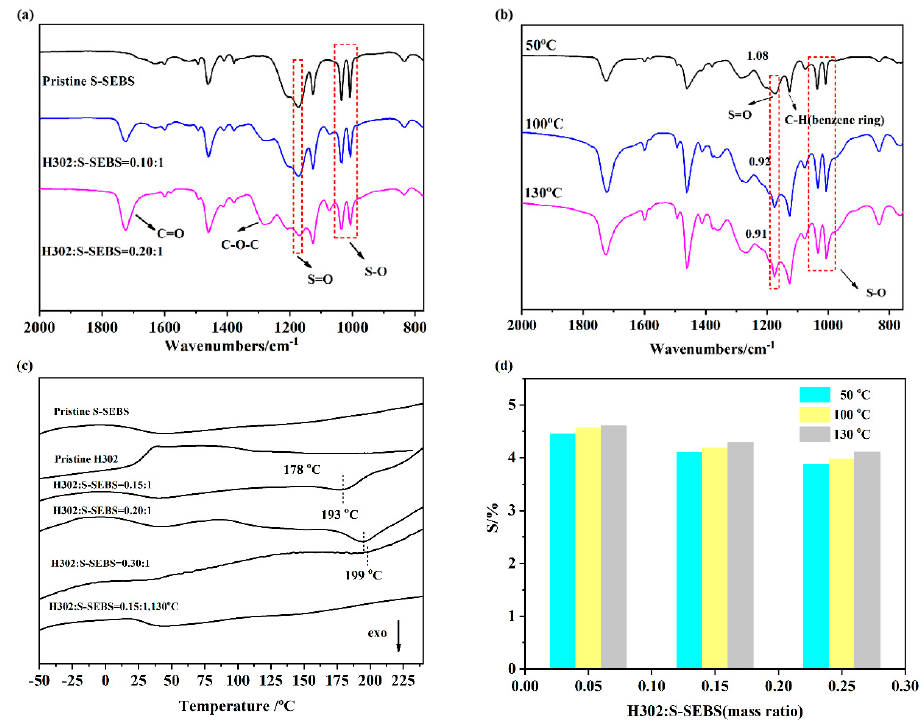
Figure 2. FTIR spectra of H302/S-SEBS membranes ( a ) without thermal treatment; ( b ) with thermal treatment (H302:S-SEBS = 0.15:1); ( c ) DSC of membranes with different contents of H302; ( d ) change of sulfur content in H302/S-SEBS membranes after thermal treatment.